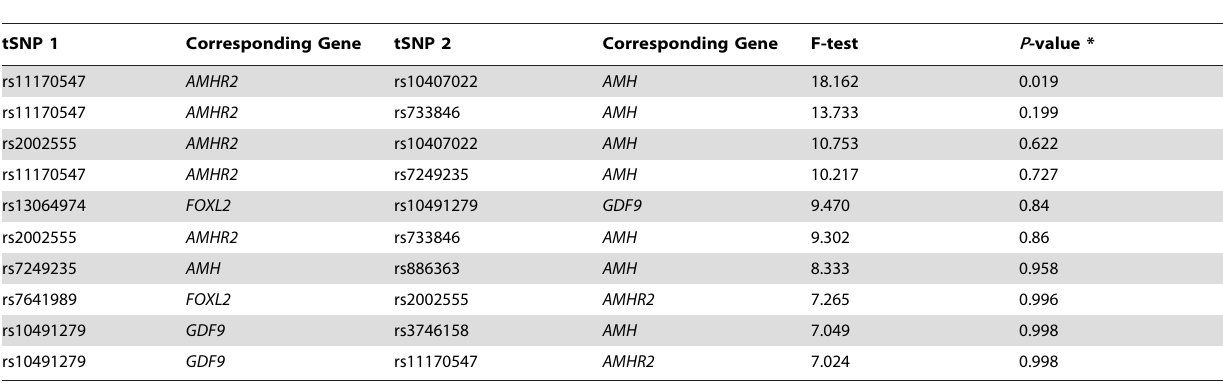
Abbreviations: tSNP, tagging Single Nucleotide Polymorphism. *P-values are reported after adjustment for multiple testing, based on a permutation-based maxT correction with 999